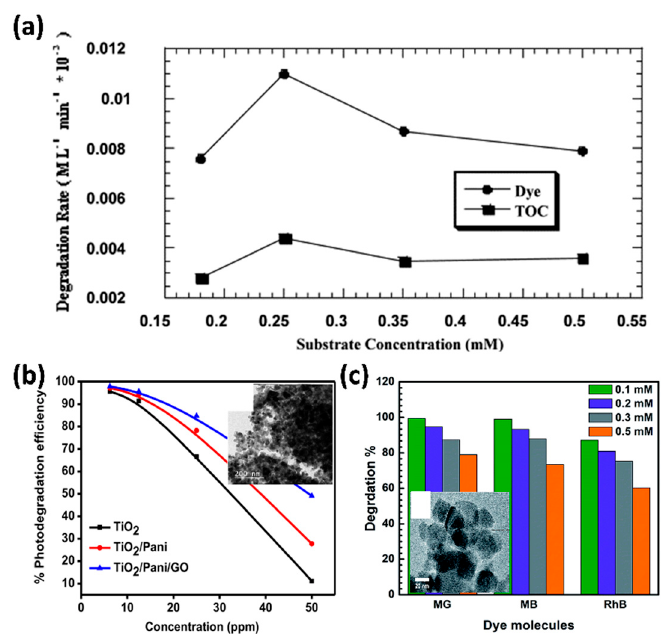
Figure 9. Effect of dye concentration for ( a ) gentian violet photodegradation on TiO 2 (reproduced with permission from [66] . Copyright Elsevier Science Publishers, 2003.); ( b ) VBB photodegradation on TiO 2 , TiO 2 /PAni, and TiO 2 /PAni/GO (reproduced with permission from [67] . Copyright John Wiley and Sons, 2018.); ( c ) MG, MB, and RhB photodegradation on Fe 3 O 4 /rGO. (reproduced with permission from [70] . Copyright Royal Society of Chemistry, 2016.) Insets of ( b ) and ( c ) are TEM images of TiO 2 /PAni/GO and Fe 3 O 4 /rGO, respectively.